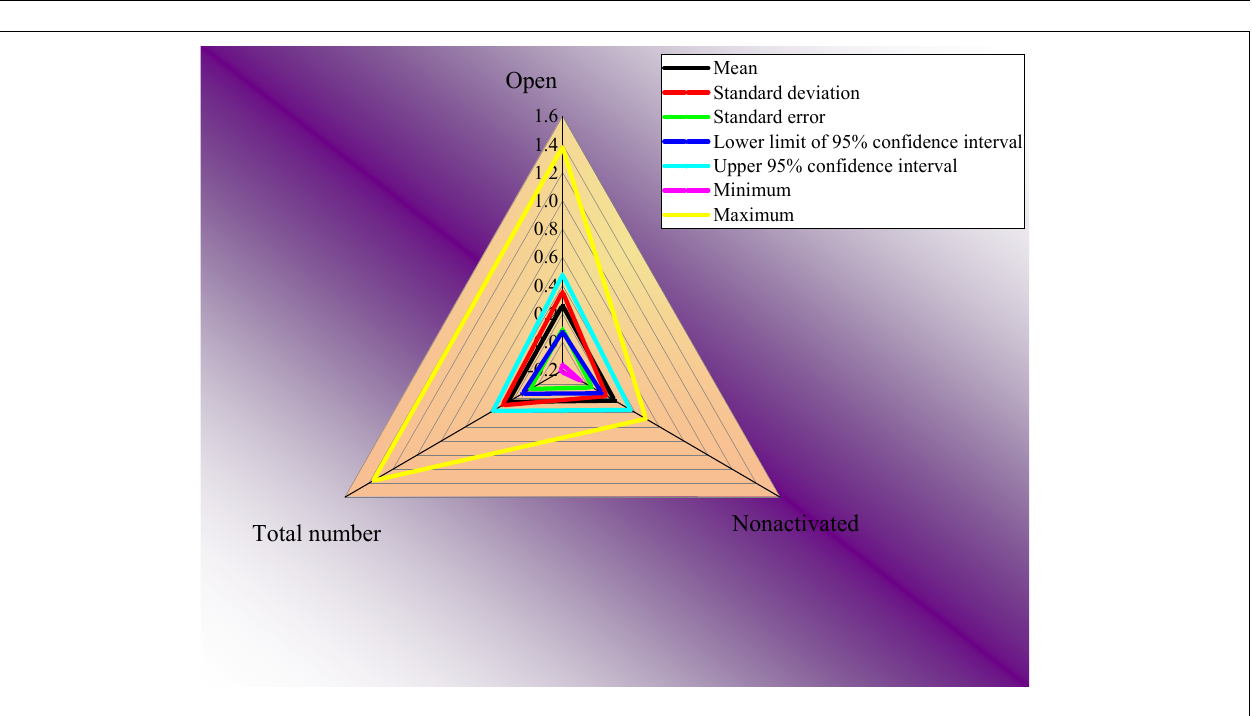
FIGURE 4 | Results of descriptive